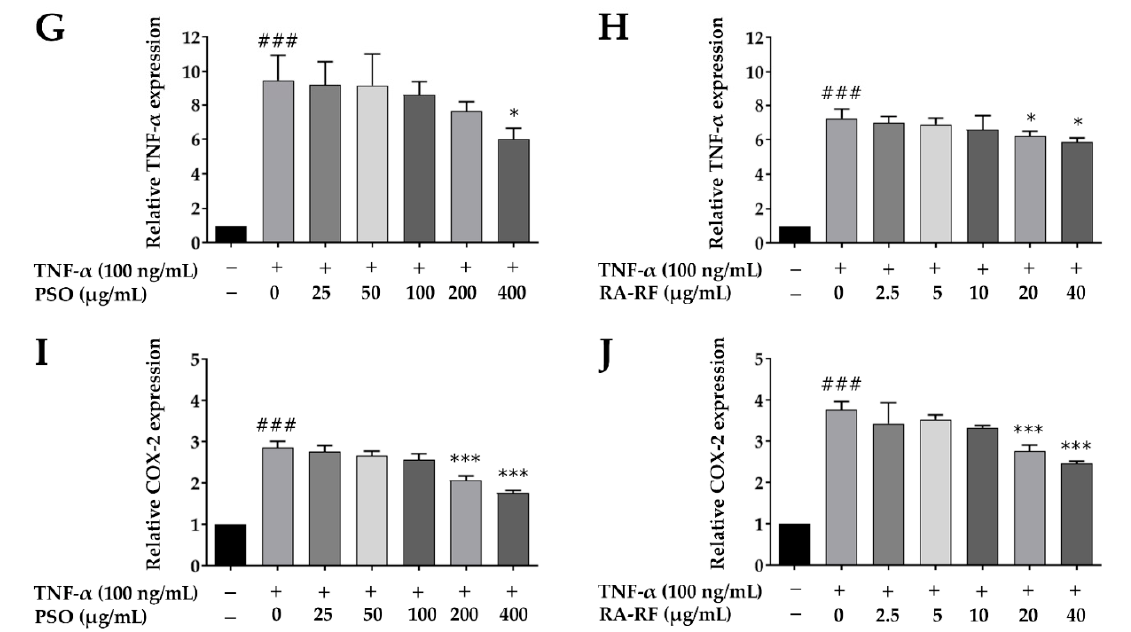
Molecules 2021 , 26 , x FOR PEER REVIEW Figure 6. Treatment with PSO and RA-RF downregulated the mRNA expression of IL-1 β ( A , B ), IL-6 ( C , D ), IL-8 ( E , F ), TNF- α ( G , H ), and COX-2 ( I , J ). All assays were performed in triplicate; data are presented as mean ± standard deviation ( ### p < 0.001 vs. the control group; * p < 0.05, ** p < 0.01, *** p < 0.001 vs. (+) TNF- α induced group).